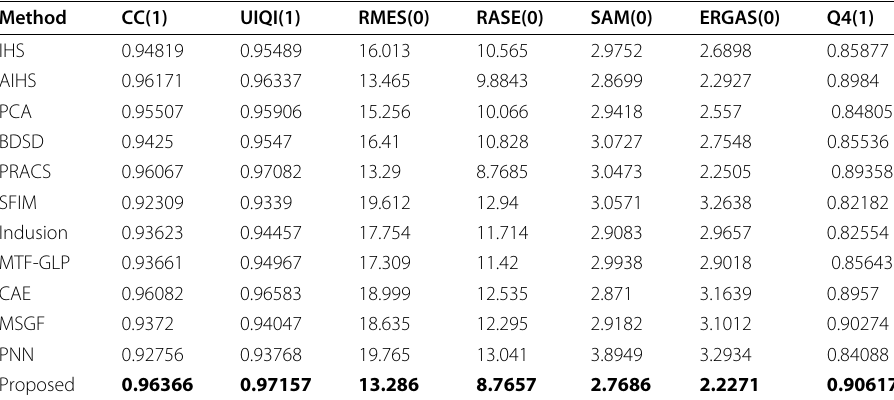
Table 3 Numerical results of the full reference QuickBird-2